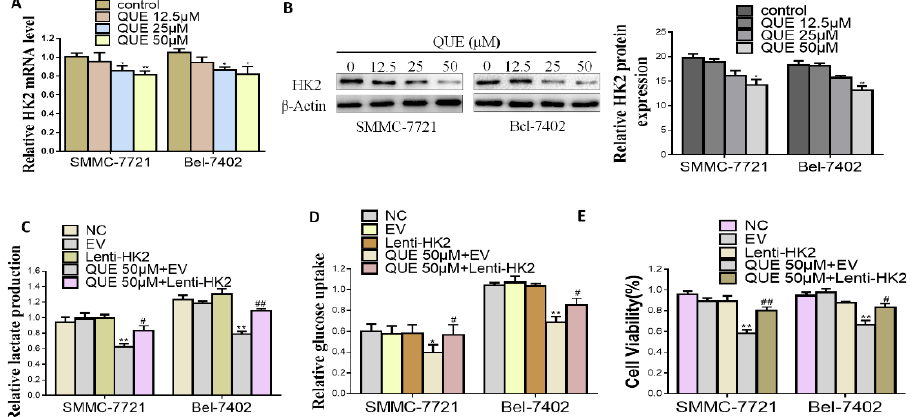
Figure 2. HK2 is essential for QUE-suppressed HCC cells glycolysis. ( A , B ) real-time polymerase chain reaction (PCR) and Western blot analyses of the e ff ect of QUE on the level of HK2. β -Actin was used as the invariant control ( C – E ) SMMC-7721 and Bel-7402 were stably transfected with Lenti-HK2 with or without QUE 50 µ M for 24 h. At the time points indicated, the following measurements were performed: lactate production ( C ), glucose consumption ( D ), cell proliferation rate ( E ). Representatives were from three parallel experiments ( * P < 0.05; ** P < 0.01 vs. NC group; # P < 0.05; ## P < 0.01 vs. EV group treated QUE). NC: negative control; EV: empty vector.